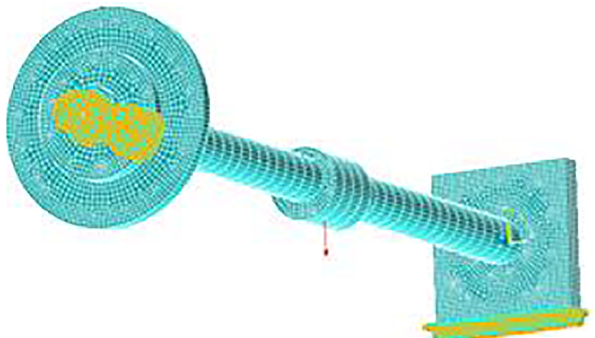
Table 3. Angular shift